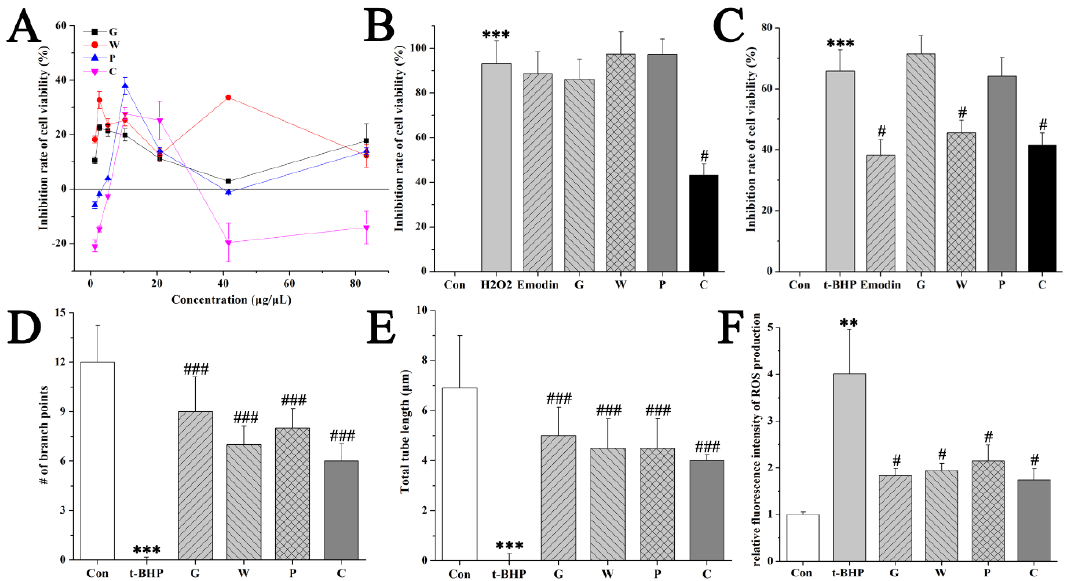
Figure 4. E ffi cacy evaluation of the crude and processed Curcuma zedoaria on oxidative liver injury by human brain microvascular endothelial cell (HBMEC) assays. ( A ) Inhibition rate of cell viability of HBMECs for MTT assays without 55 µ M H2O2 or 40 µ M t-BHP. ( B – C ) Inhibition rate of cell viability of HBMECs for MTT assays with 55 µ M H2O2 or 40 µ M t-BHP. ( D – E ) The crude and the processed Curcuma zedoaria confronted the inhibition of angiogenesis by 40 µ M t-BHP. ( F ) Relative fluorescence intensity of HBMECs induced by 40 µ M t-BHP and / or the crude and the processed Curcuma zedoaria (83.33 mg / mL) by ROS assay. Con, control group treated with PBS; Mod, model group treated with 55 µ M H2O2 or 40 µ M t-BHP; Pos, positive control group treated with emodin (12.5 µ g / mL); G, W, P, C, cells treated with Curcuma kwangsiensis S. G. Lee et C. F. Liang, Curcuma wenyujin Y. H. Chen et C.Ling, Curcuma phaeocaulis Val., and vinegar-processed Curcuma zedoaria at doses of 83.33 mg / mL, respectively. ANOVA with the post hoc test was used to calculate the significance of the di ff erences, *** represents p < 0.001 compared with the control group; #, and ### represent p < 0.05, and p < 0.001 compared with the model group, respectively. All experiments were performed three times, and the results are expressed as the mean ±